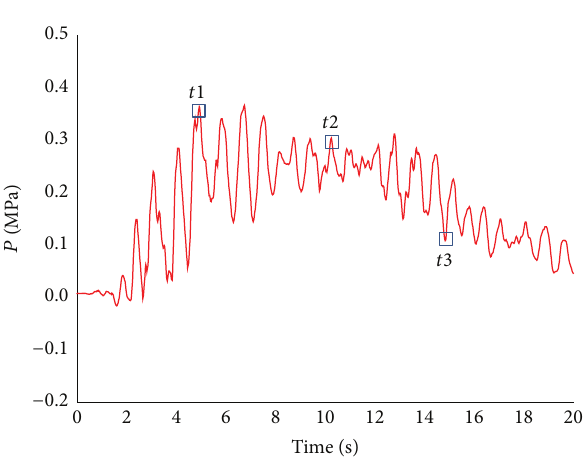
Figure 6: Hydrodynamic pressure time history curve of monitoring point B.